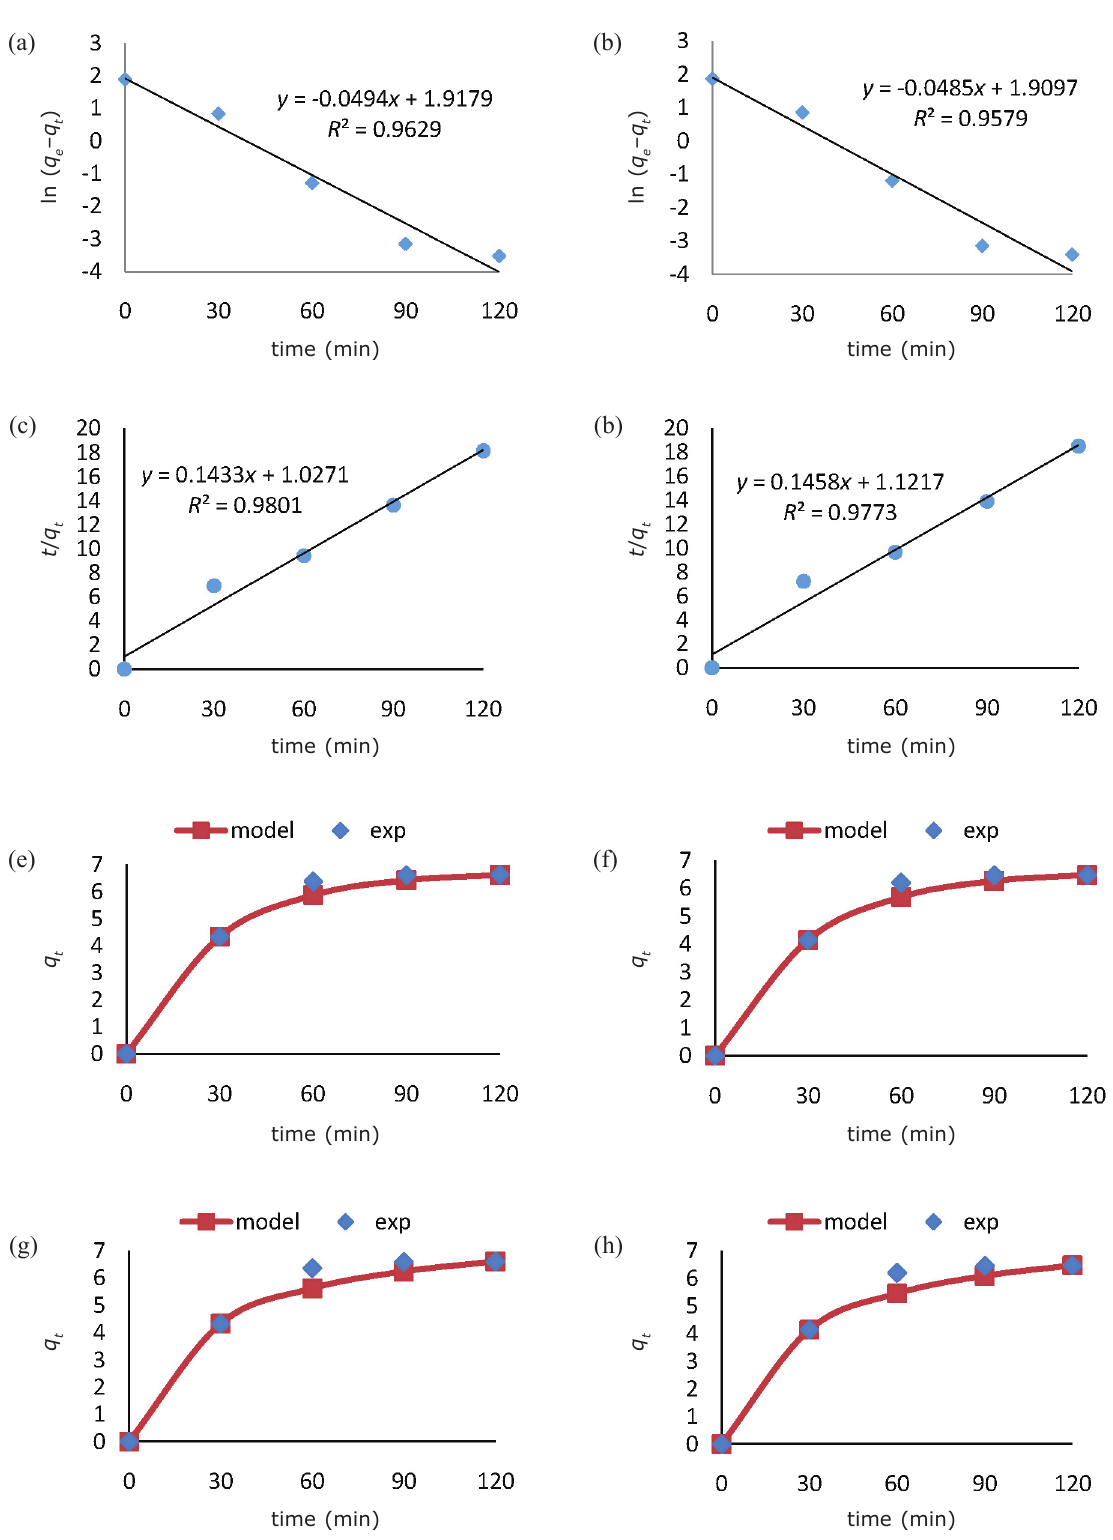
Fig. 9 – Adsorption kinetics modeling of E2 and E1 hormones on rice husk silica. Linear pseudo-first-order kinetic for E2 (a), linear pseudo-first-order kinetic for E1 (b), linear pseudo-second-order kinetic for E2 (c), linear pseudo-second-order kinetic for E1 (d), non-linear pseudo-first-order kinetic for E2 (e), non-linear pseudo-first-order kinetic for E1 (f), non-linear pseudo-second-order kinetic for E2 (g), non-linear pseudo-second-order kinetic for E1